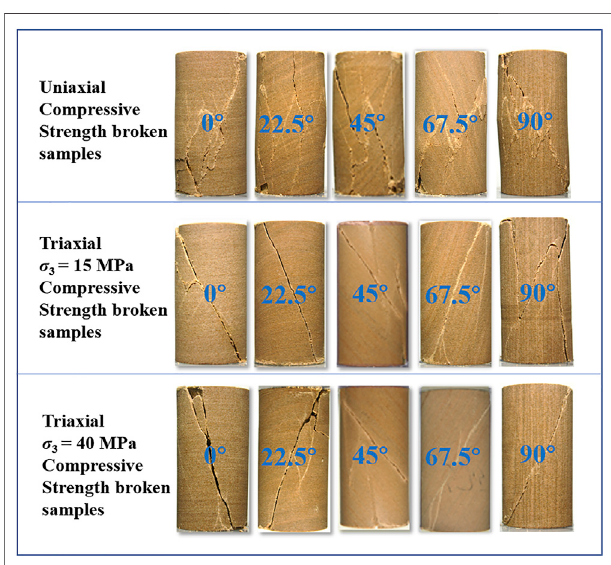
FIGURE 7 | Failure characteristic of rock A with different bedding dip angles after the triaxial